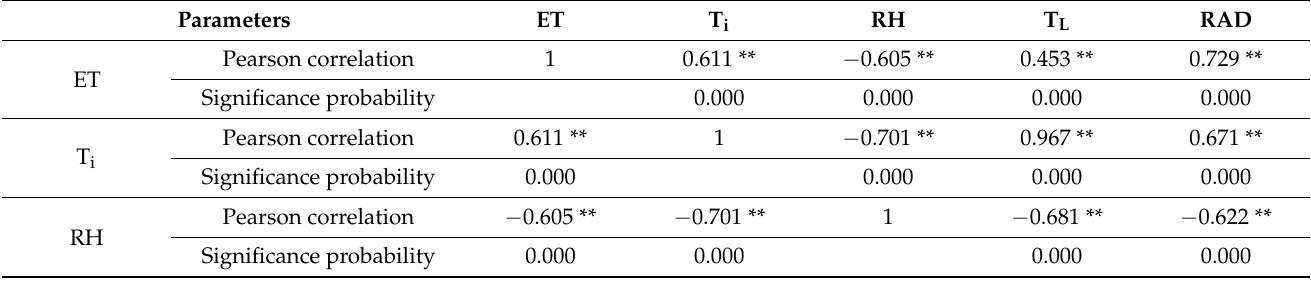
Table 4. Pearson correlation analysis for environmental variables (ET, T i , RH, T L , RAD) of the greenhouse.